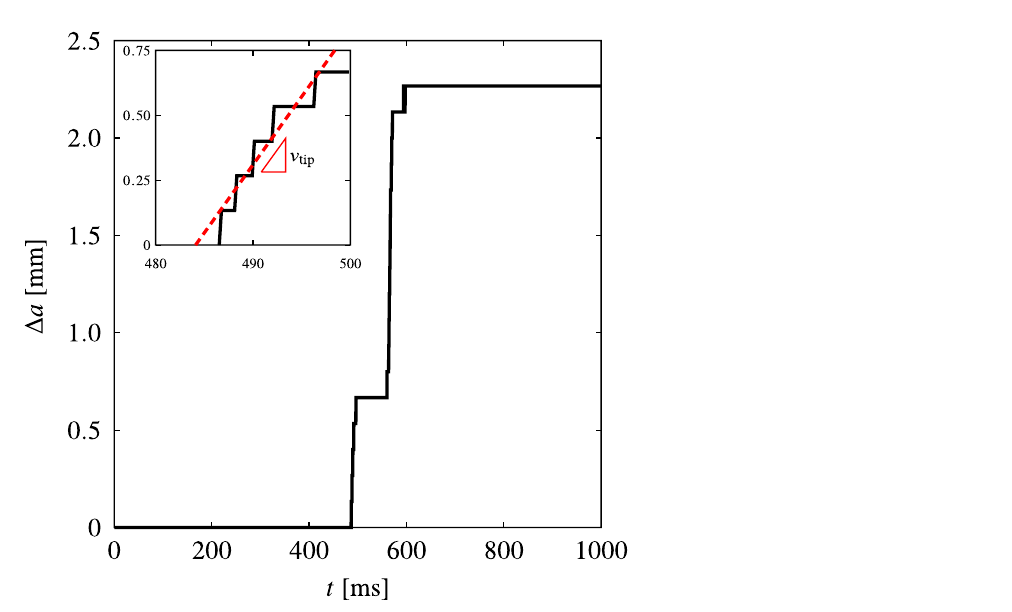
Figure 7. The crack extension vs